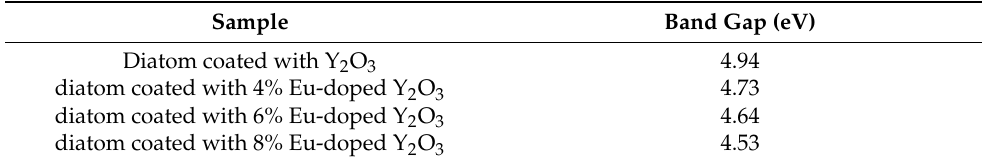
Table 3. Bandgap energy of diatom coated with Eu-doped Y 2 O 3 nanostructures.